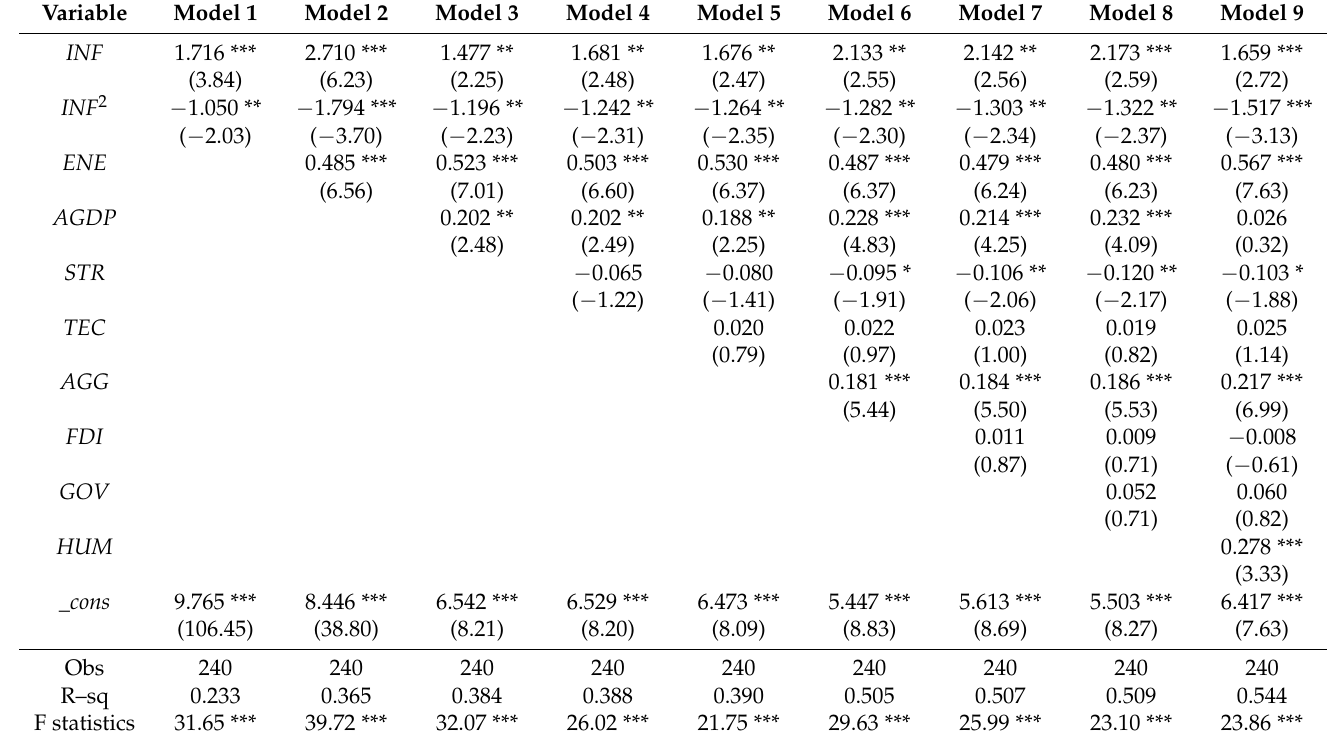
Table 5. Results of the impact of integrated infrastructure on carbon